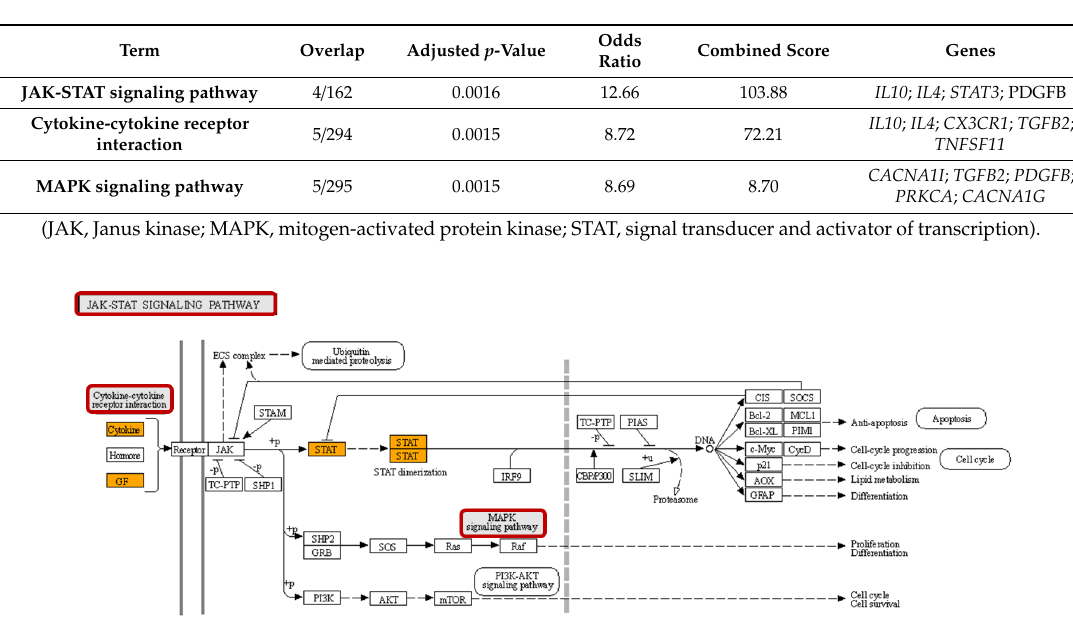
Figure 6. JAK-STAT signaling pathway (hsa04630) and the targets of brevilin A. The pathway maps were constructed using KEGG mapper. Round square and square represent pathways and gene targets, respectively. Red-rimmed round squares and orange-colored boxes indicate significantly associated pathways (adjusted p-value < 0.05) for targets of brevilin A and targets predicted to interact with the compounds of brevilin A, respectively. JAK, Janus kinase; STAT, signal transducer and activator of transcription.